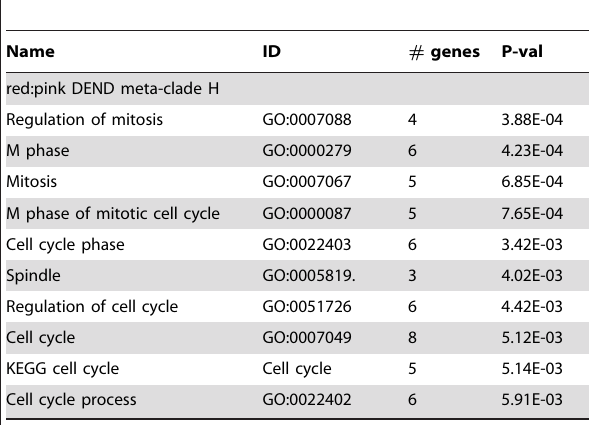
Table 1. GSEA results for DEND meta-clade H (red:pink) for ASPS-1 over expressed genes relative to